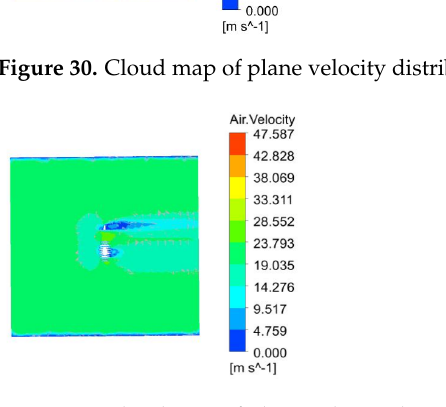
Figure 31. Cloud map of plane velocity distribution at the side view